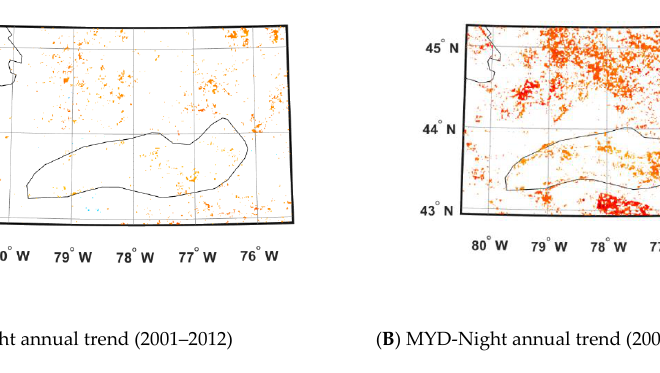
Figure 5. Annual trends (K year − 1 ) from MOD11A2 and MYD11A2 nighttime LSWT for the periods of 2001/2003 − 2018 ( a , b ) and 2001/2003 − 2012 ( A , B ). Boxplots ( a1 , b1 ): For each box, the central value indicates the median, and the lower and top edges of the box indicate the 25th and 75th percentiles, respectively. The whiskers extend to the most extreme data points not considered outliers, and the outliers are plotted individually using the “+” symbol. The HydroLAKES database (http://wp.geog.mcgill.ca/hydrolab/, accessed on 1 May 2021) was used to differentiate lake and land. The ground sites trend from MOD over 2001 − 2018 ( a2 ) and MYD over 2003 − 2018 ( b2 ). The dotted lines are the linear regression lines for different time periods, including 2001/2003 − 2018, 2003 − 2012 and 2012 −